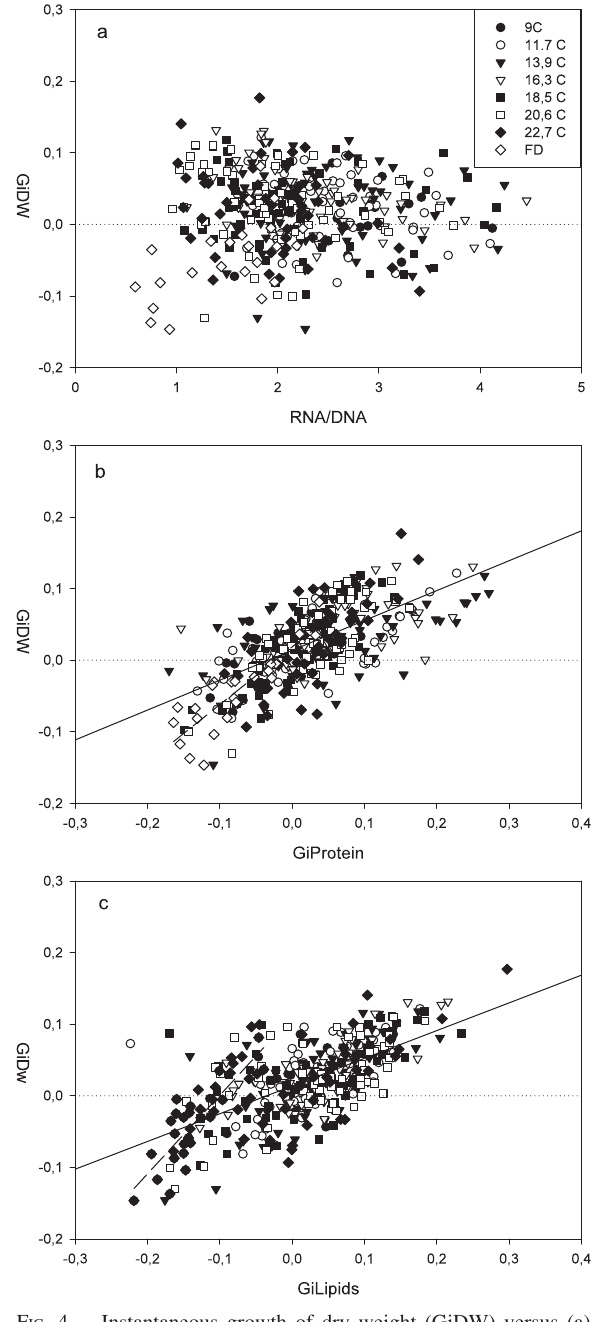
F IG . 4. – Instantaneous growth of dry weight (GiDW) versus (a) RNA/DNA, (b) change in protein (GiP) and (c) change in lipids (GiL) over 7 days for fed fish at 7 different temperatures and the food-deprived control group (FD). Regression curves for pooled temperatures are given in Table